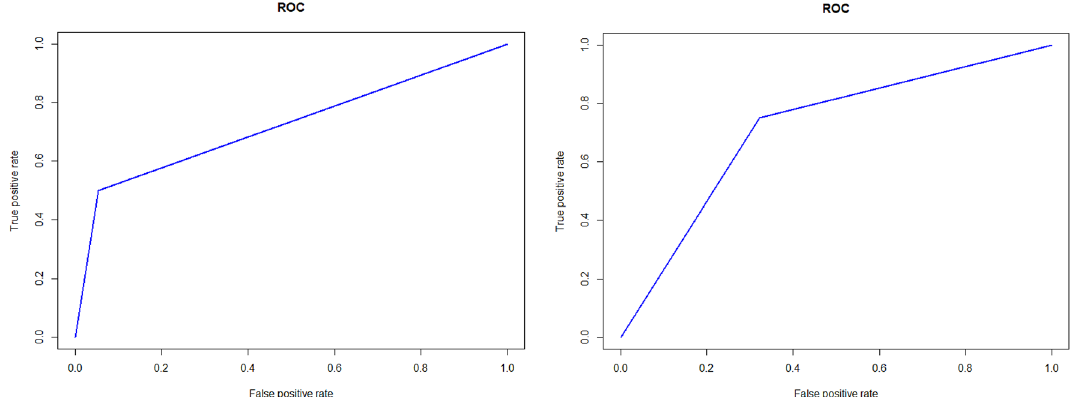
Figure 2. (Left) ROC (receiver operating characteristics) curve of neuralnet prediction package. AUC was 0.79. (Right) ROC (receiver operating characteristics) curve of nnet prediction package. AUC was 0.75. R program version 3.6.3 (The R Foundation for Statistical Computing, Vienna, Austria) was used in creating diagram.